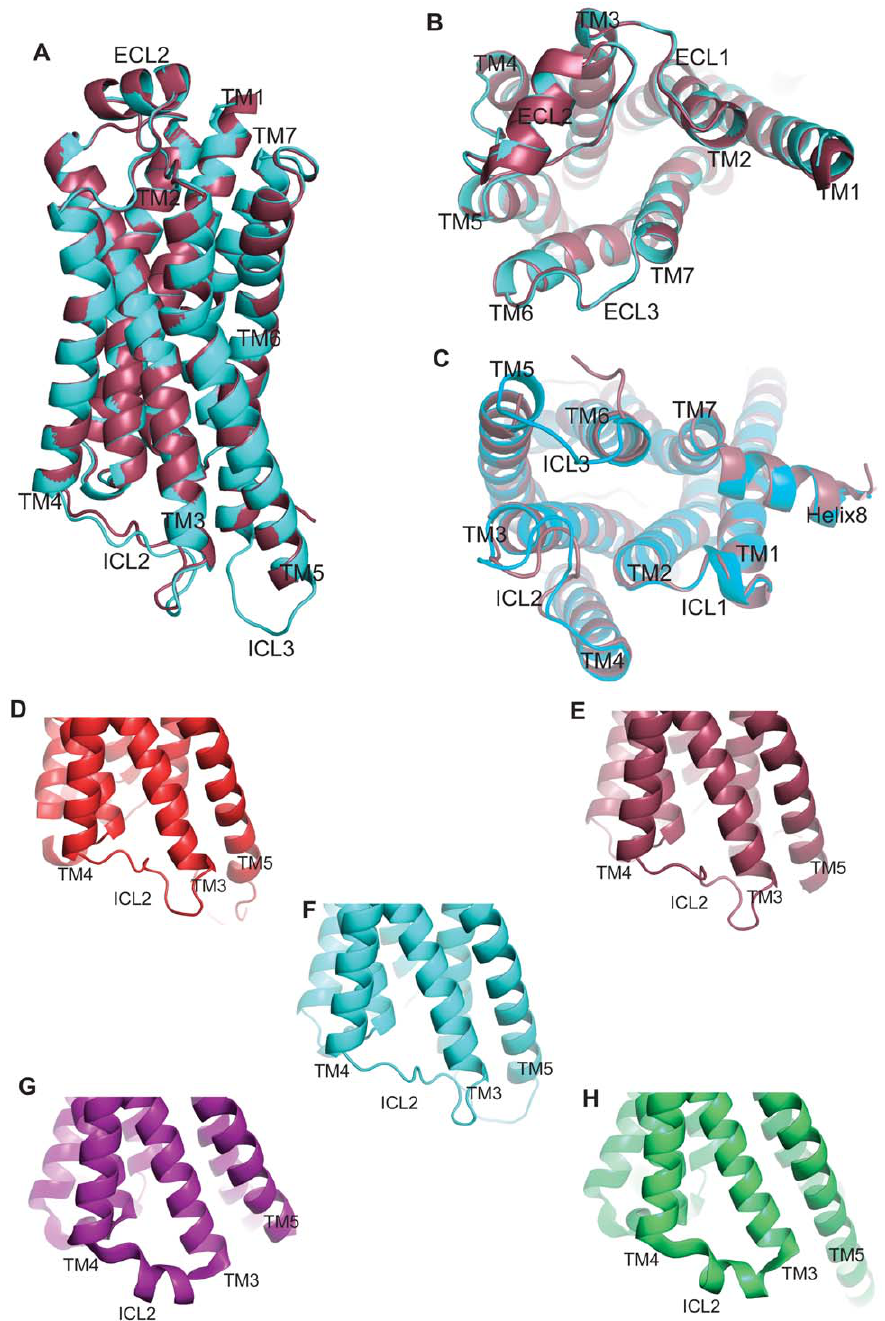
Figure 6. Structural comparison between T4L- b 2AR- D ICL3 and some other b 2 AR structures. A. The superimposed structures of the T4L- b 2 AR- D ICL3 and the b 2 AR-T4L (pdb 2RH1). The T4L- b 2 AR- D ICL3 is shown in cyan and the b 2 AR-T4L is shown in raspberry. B. The extracellular side view of the superposed structures. C. The intracellular side view of the superposed structures. D. ICL2 in the b 2 AR-Fab5 structure (pdb 2R4R). E. ICL2 in the b 2 AR-T4L structure (pdb 2RH1). F. ICL2 in the T4L- b 2 AR- D ICL3 structure. G. ICL2 in the structure of b 2 AR stabilized by Nb80 (pdb 3P0G). H. ICL2 in the b 2 AR-Gs structure (pdb 3SN6). doi:10.1371/journal.pone.0046039.g006 CWLPFFIVNIVHVIQDNLIRKEVYILLNWIGYVNSGFNPL- is shown with an asterisk; the full length T4L is shown in orange; IYCRSPDFRIAFQELLCLRRSSLKAYGNGYSSNGNTGEQ- the b 2 AR sequence from Asp29 to Gly365 excluding Ser235 to SG K263 is shown in cyan, the 2-Ala linker is shown in blue). (the HA signal peptide is shown in italic letters; the FLAG The entire T4L- b 2 AR- D -ICL3 gene described above was epitope tag is shown in letters with underscore; the TEV further cloned into the Best-Bac Sf9 expression vector pvl1393 recognition sequence is marked with a box and the cleavage site (Expression Systems, Woodland, CA) using the restriction enzyme